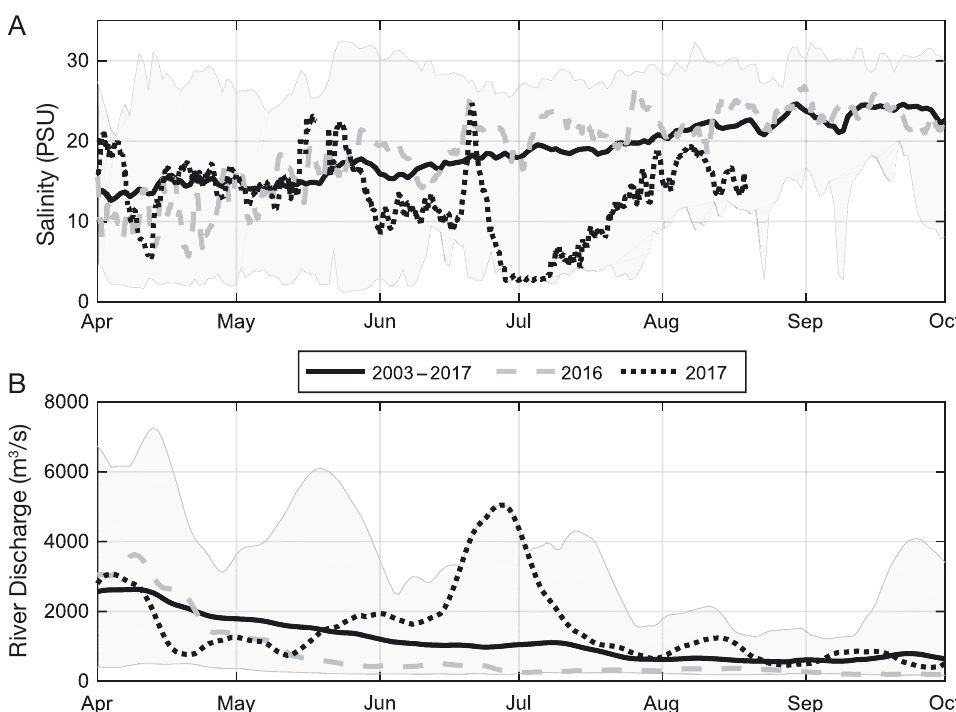
Fig. 9. (A) Subtidal salinity at Dauphin Island (DI), comparing salinity during 2016 (gray dashed line) and 2017 (black dotted line) to the average salinity over 2003−2017 (solid black line with shaded range indicating maximum and minimum). Salinity at the DI site ranged on average from 11−25 PSU. (B) River discharge into Mobile Bay from the Alabama and Tombigbee rivers over the same time